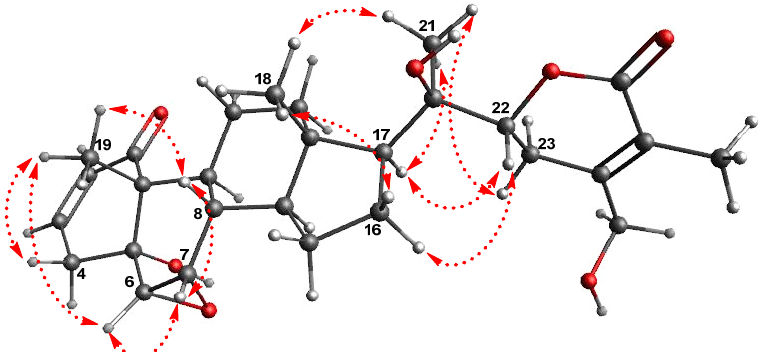
Figure 3. Key rotating-frame Overhauser enhancement spectroscopy (ROESY) correlations for 1 .